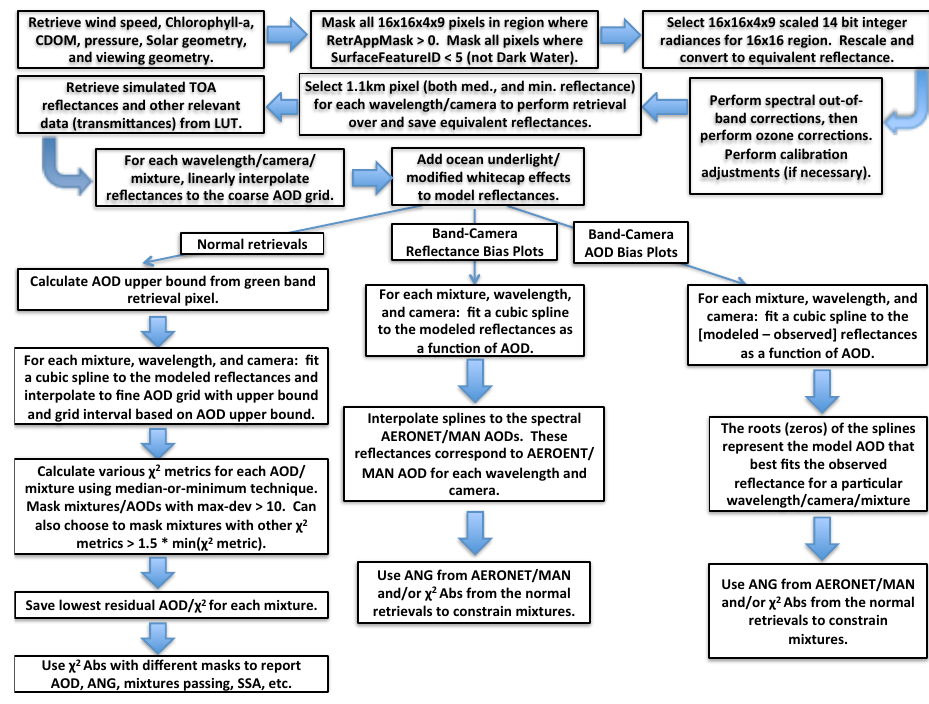
near-nadir view angles, whereas the aerosol optical model is more likely to dominate at steeper view angles and higher AOD, and will depend on the dominant aerosol type in a given